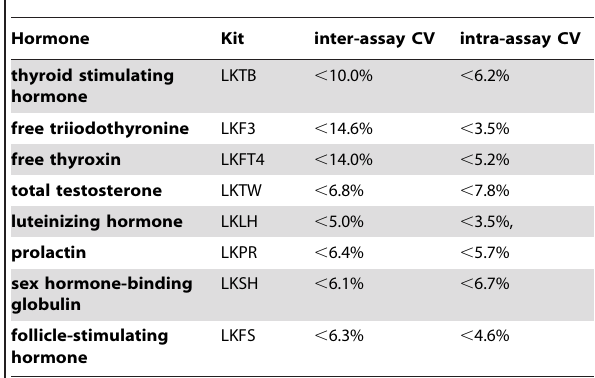
Table 1. Characteristics of assays